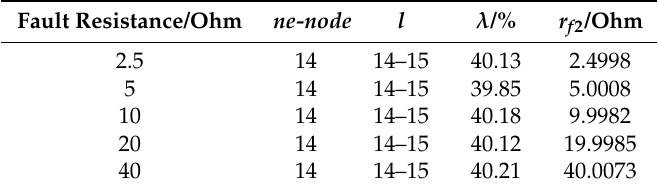
Table 11. Locating results of Strategy for Case 1 under the neutral ungrounded. Fault Resistance/Ohm Fault